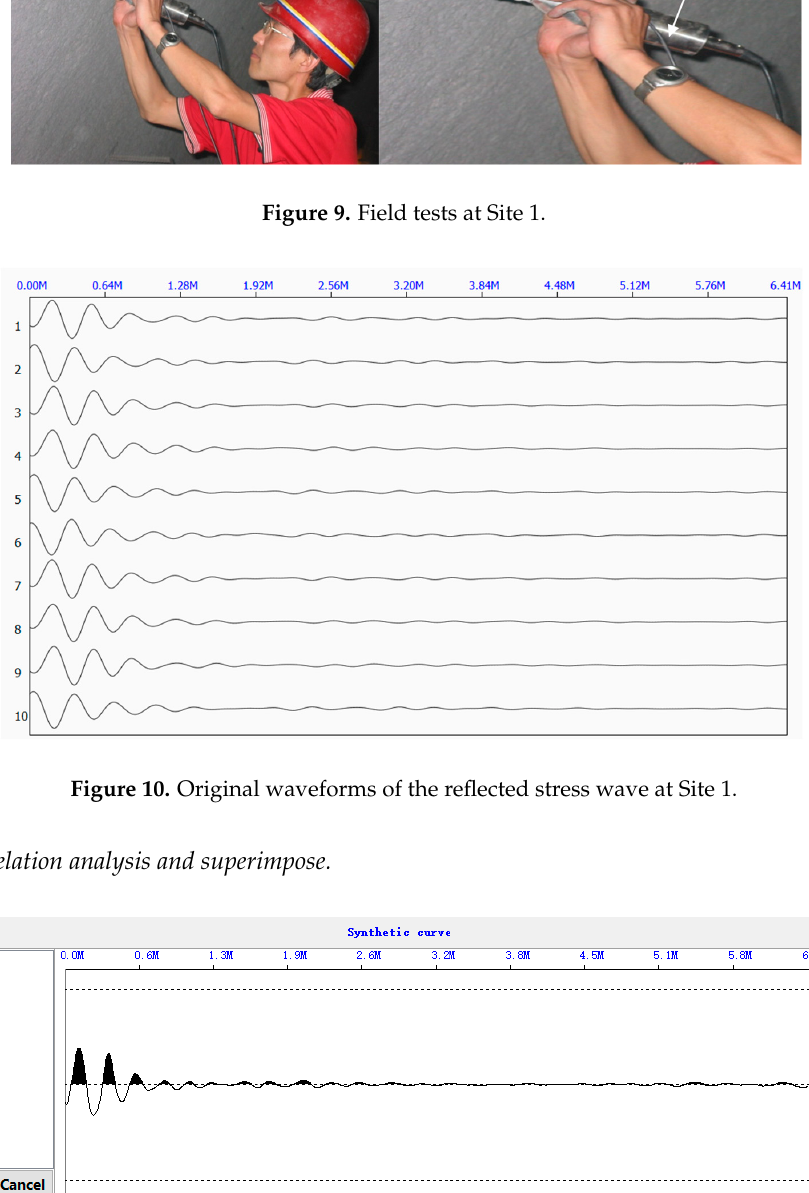
Figure 11. Superimposed waveforms at Site 1.